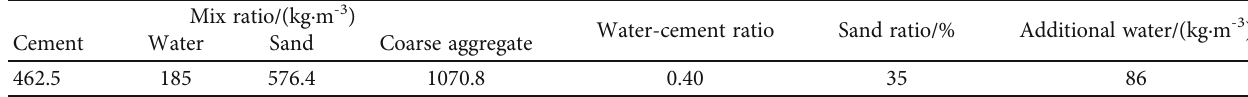
Table 3: Preliminary mix